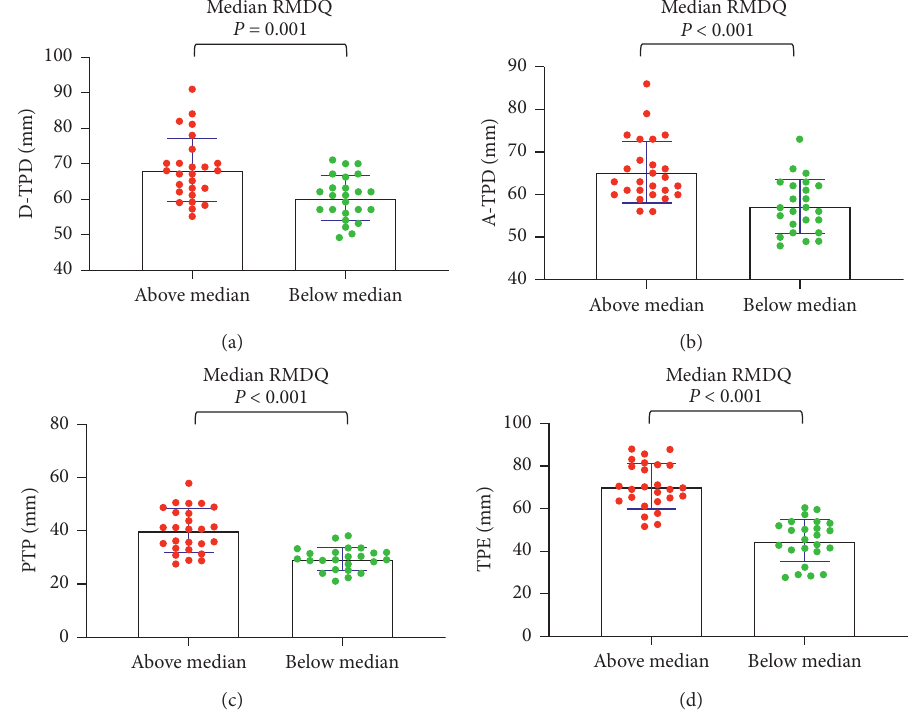
Figure 6: Tactile acuity for median RMDQ in the abovemedian group versus the belowmedian group. (a) D-TPD, (b) A-TPD, (c) PTP, and (d) TPE. The median of RMDQ was 6. D-TPD � two-point discrimination test performed in a descending manner; A-TPD � two-point discrimination test performed in an ascending manner; PTP � point-to-point test; TPE � two-point estimation; RMDQ � Roland-Morris Disability